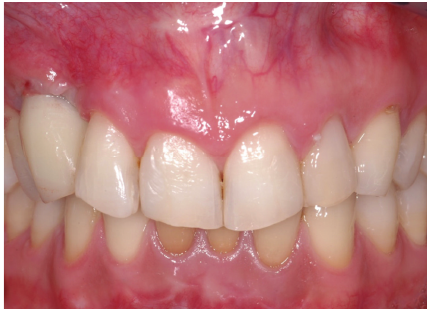
Figure 19: New temporary crown placed and adapted to the recipient site.